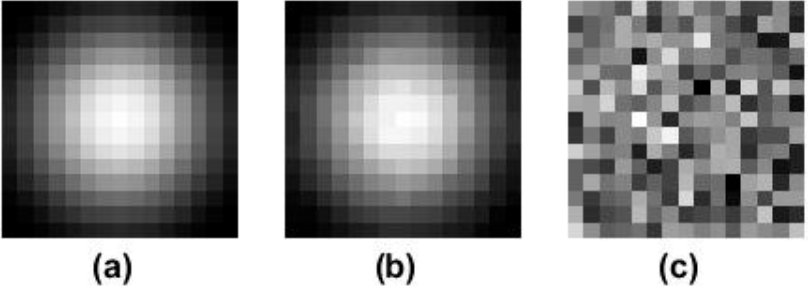
Figure 8. Results of the point spread function in Figure 4 (SNR = 40 dB, Sampling Ratio = 0.8). ( a ) the point spread function; ( b ) the estimated point spread function; ( c ) the difference between point spread function and the estimated point spread function. Table 2. Peak signal-to-noise ratio ( PSNR) average performance comparison of the proposed algorithm with a series of algorithms, namely, SART [3], SART + TV [13], Patch + ordering Wavelet [14] (SNR = 40 dB).